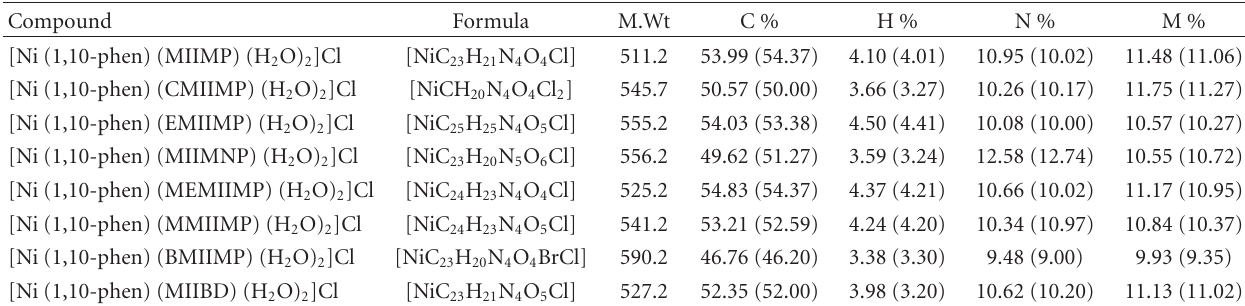
Table 1: Analytical data for Ternary Ni(II)